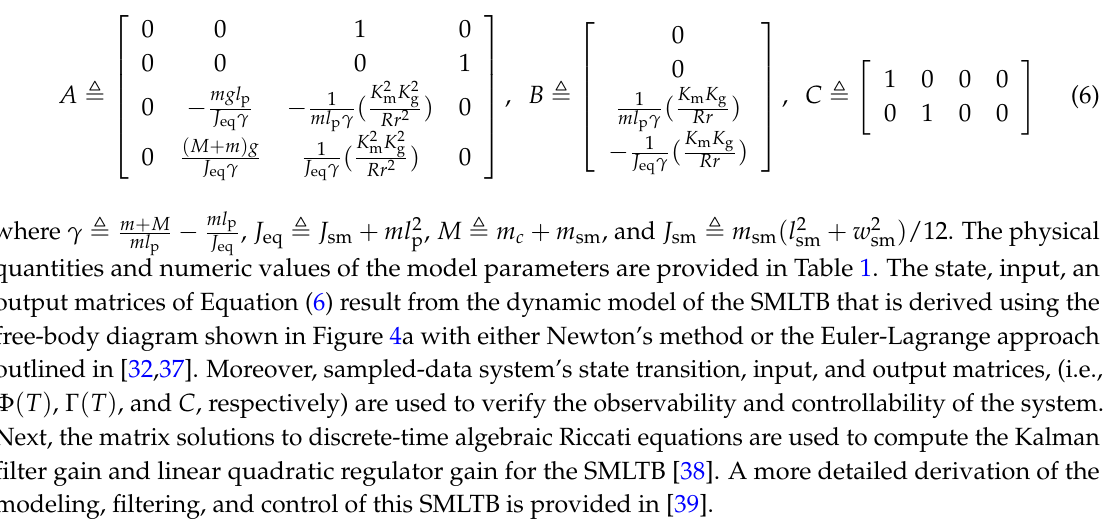
Table 1. Numerical values for physical parameters of the IPC system.